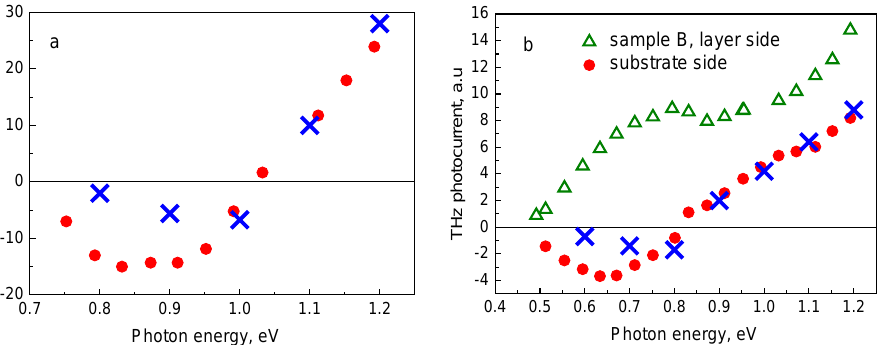
Figure 3. THz excitation spectra of GaInAs/InP ( a ) and GaInAsBi/InP ( b ) heterostructure samples measured for cases of the layer-side photoexcitation (empty green triangles) and the substrate-side photoexcitation (full red circles). Blue crosses show the Monte Carlo simulation results.